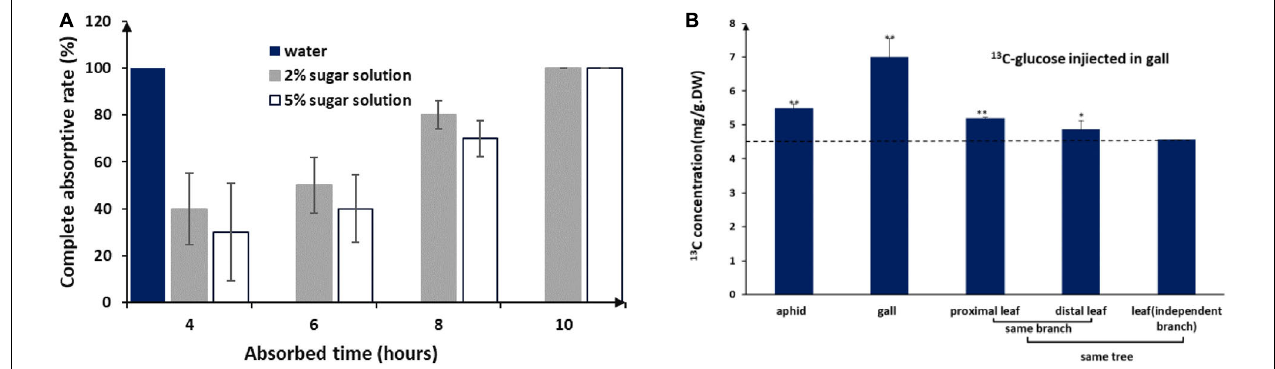
FIGURE 3 | Honeydew absorption and 13 C-glucose tracing. (A) Completed absorption rate of water and sugar solutions by gall tissues. (B) 13 C distribution in aphids and different plant tissues after 3 days of consecutive injections of 13 C-glucose into the gall (LSD test). ** represent P < 0.01, * represent P < 0.02.